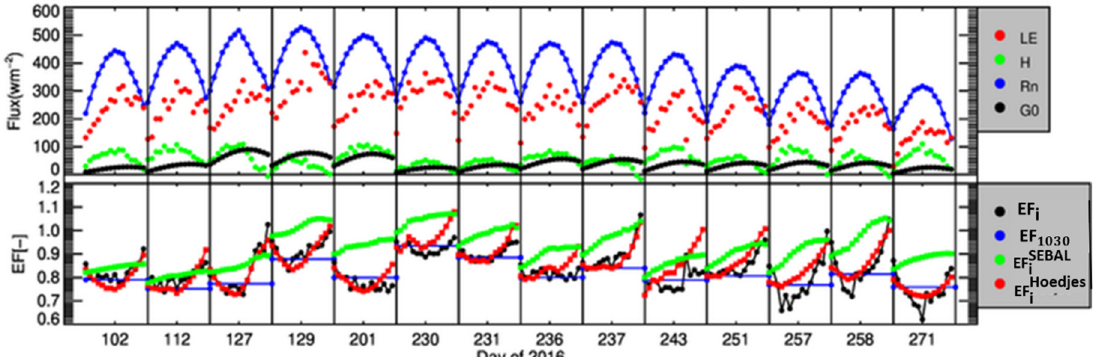
Figure 5. The diurnal cycle of surface flux and evaporative fraction (EF) at the Veenkampen site, for the 13 selected clear days during 2016. The course of surface fluxes include latent heat flux, sensible heat flux, net radiation and surface soil heat flux incoming (LE, H, Rn, and G0, respectively in the up panel); The comparison of four types of EF including observed instantaneous EF, constant EF, SEBAL corrected EF and Hoedjes corrected EF ( EF i , EF 1030 , EF (cid:2919)(cid:2903)(cid:2889)(cid:2886)(cid:2885)(cid:2896) , and EF (cid:2919)(cid:2892)(cid:2925)(cid:2915)(cid:2914)(cid:2920)(cid:2915)(cid:2929) , respectively in the down panel).